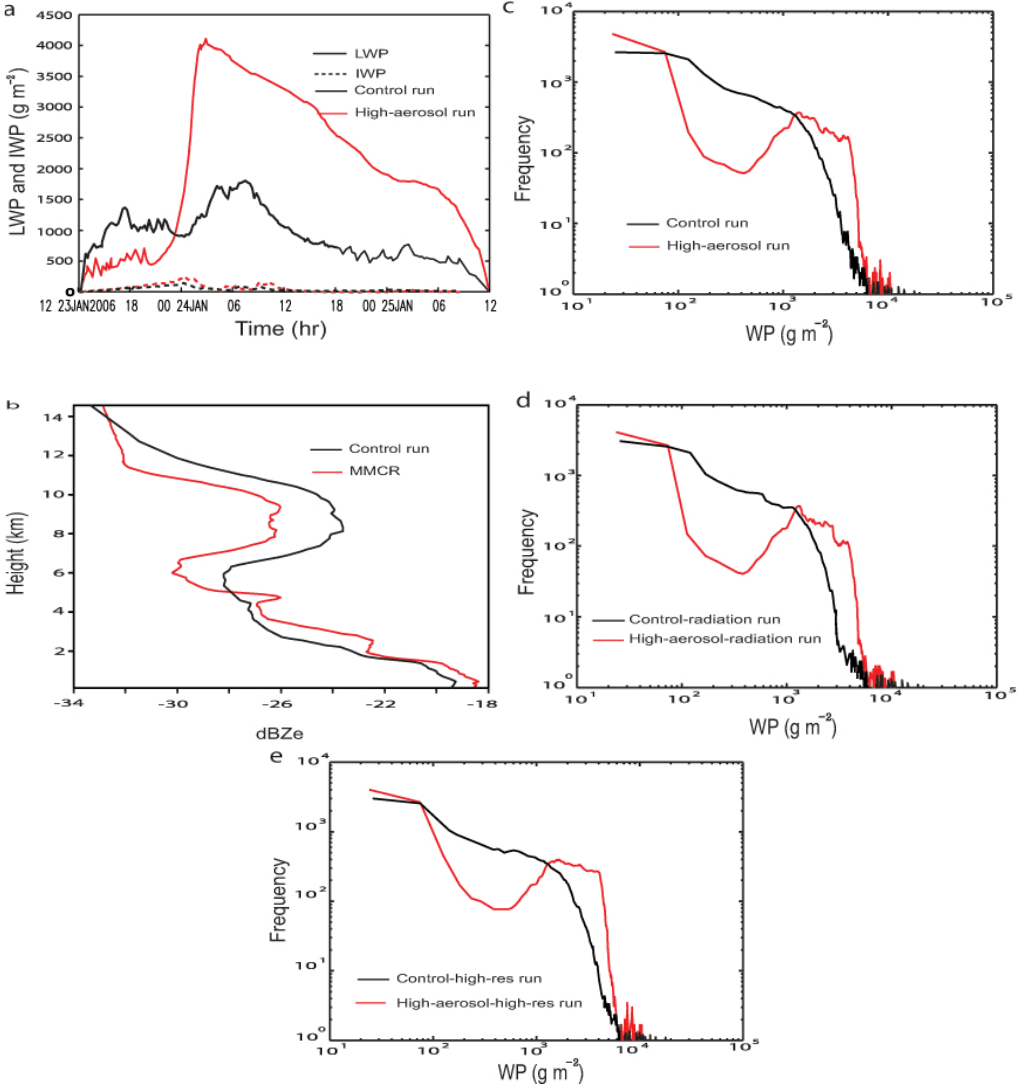
Fig. 3. (a) Time series of liquid-water path (LWP) and ice-water path (IWP), (b) vertical distribution of the time- and domain-averaged radar reflectivity (units: dBZ e ) in the control run and the time-averaged radar reflectivity from a millimeter wave cloud radar (MMCR) and (c) frequency distribution of water path (WP = LWP + IWP) for the entire simulation period for the control and high-aerosol runs. (d) As in (c) but for the fixed radiation simulations (control–radiation, high-aerosol–radiation); (e) as in (c) but for the high-resolution simulations (control–high-res and